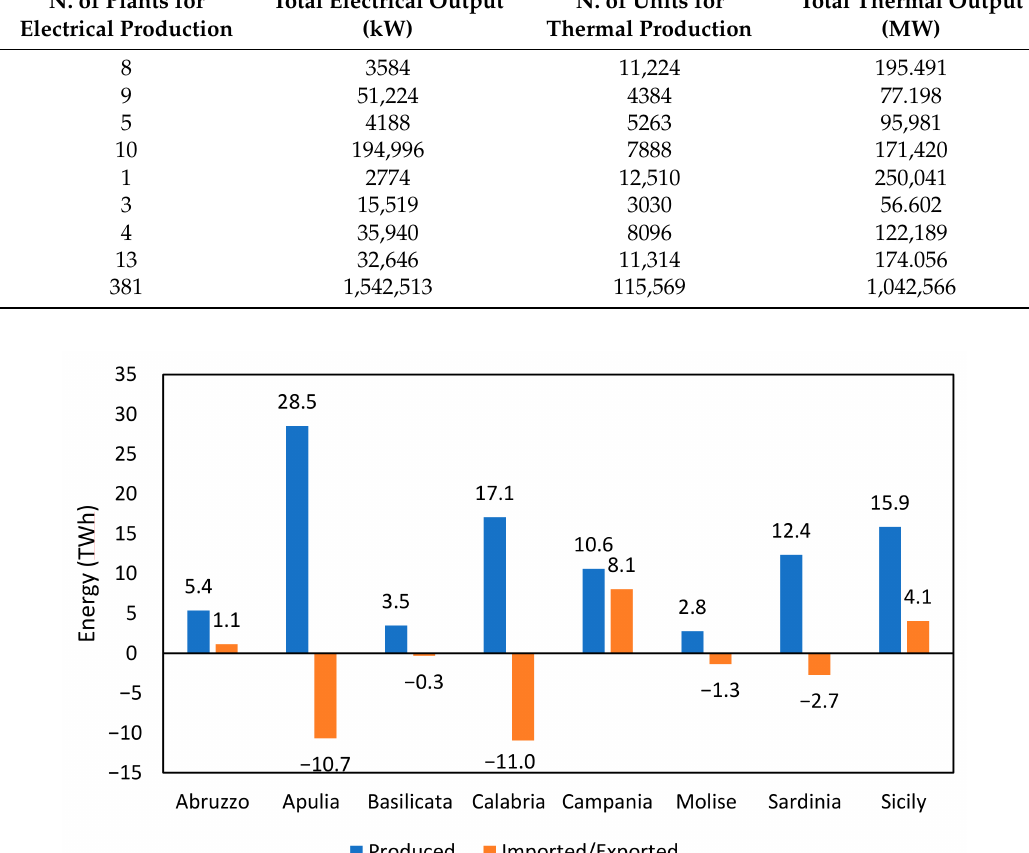
Table 10. Number and power output of solid-biomass-to-energy units (Source: GSE Atlaimpianti [53]). N. of Plants for Region